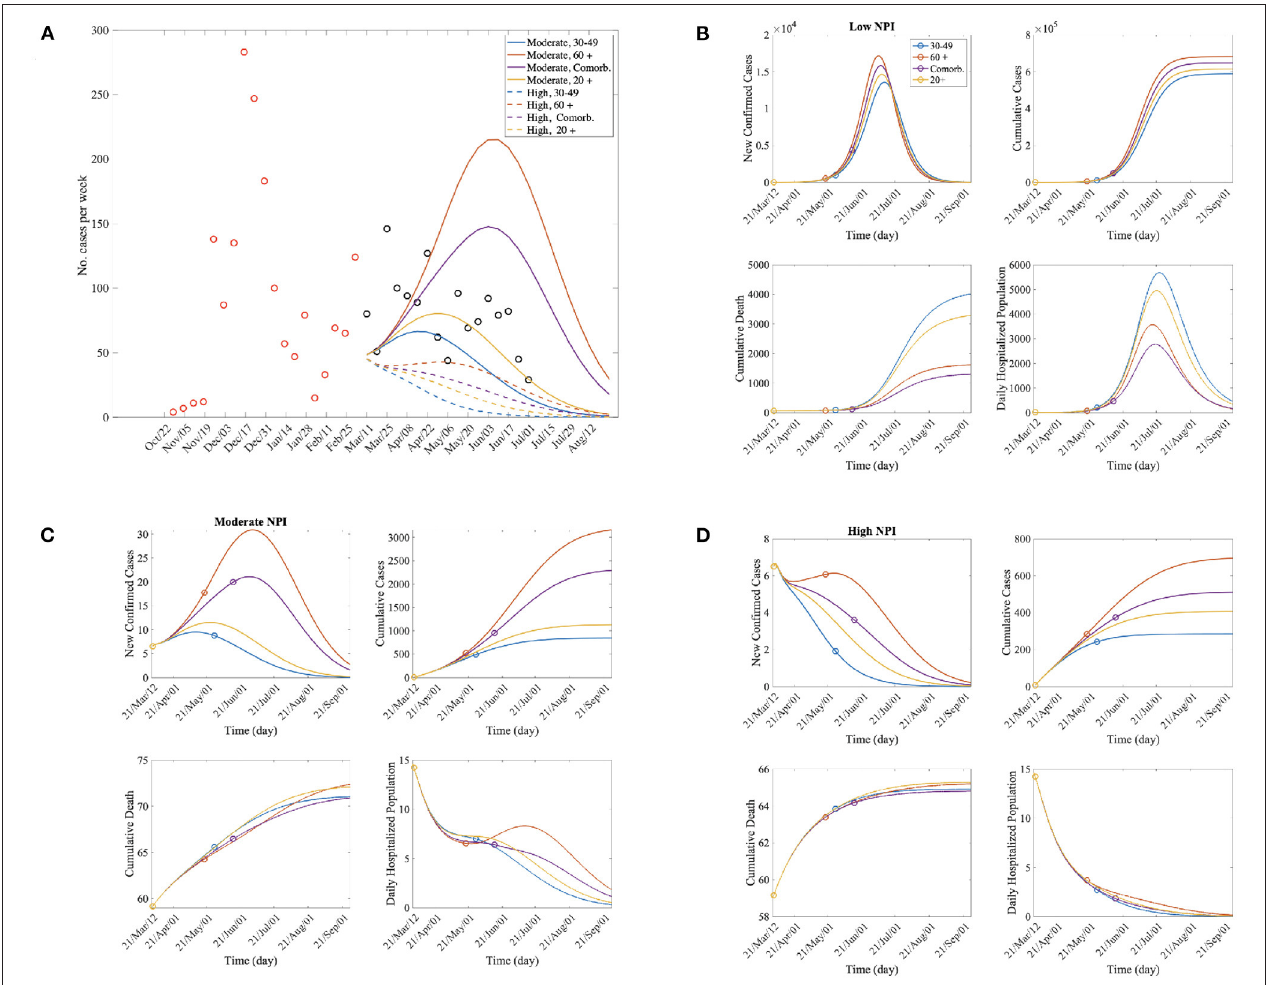
FIGURE 3 | (A) The red and black circle represent the number of confirmed cases per week before and after vaccination, respectively. The number of confirmed cases is similar to the results obtained for the moderate NPI-level simulation. (B–D) Time series of new confirmed cases, cumulative confirmed cases, cumulative death, and daily hospitalized population for each vaccination priority scenarios; For each curve, the circle represents the end point of priority vaccination for a specific group according to the vaccination